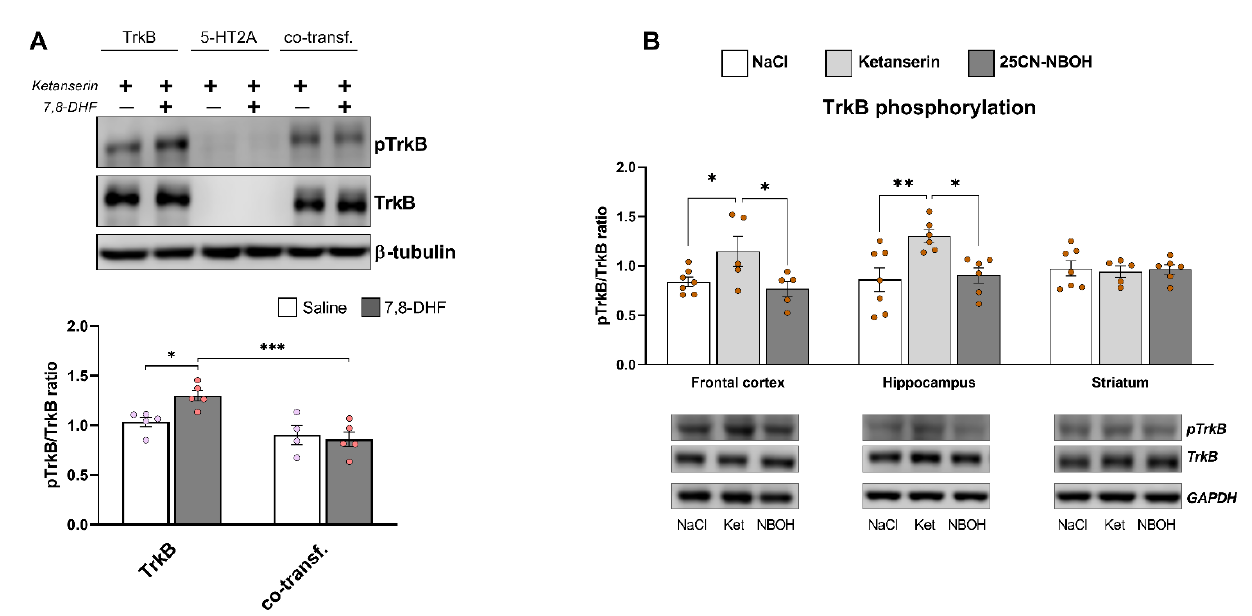
Figure 6. Blockade of 5-HT 2A with ketanserin reversed TrkB autophosphorylation in vitro and in vivo. ( A ) Neuroblastoma N1E-115 cells expressing HA-tagged 5-HT 2A receptor, GFP-tagged TrkB, or co-expressing both receptors were treated with the 5-HT 2A receptor antagonist ketanserin (1 μM) for 10 min, followed by treatment with either 7,8-DHF (500 nM) or vehicle for 30 min. Cell lysates were then subjected to SDS-PAGE and Western blot (WB) analysis with antibodies against phosphorylated or total TrkB. β -tubulin was used as a loading control. Representative WBs are shown. Bars show means ± SEM ( n ≤ 8). * p < 0.05; *** p < 0.001 (two-way ANOVA). ( B ) Mice were intraperitoneally injected with ketanserin (1 mg/kg) or 25CN-NBOH (1 mg/kg), resulting in increased TrkB phosphorylation in the hippocampus and frontal cortex. At 10 min (for 25CN-NBOH) or 30 min (for ketanserin) after injection, the animals were euthanized, and brain lysates were prepared from the frontal cortex, hippocampus, and striatum. This was followed by SDS-PAGE and WB to detect phosphorylated and total TrkB. GAPDH was used as a loading control. Representative WBs are shown. Bars represent means ± SEM (5 ≤ n ≤ 8) * p < 0.05; ** p < 0.01 (two-way